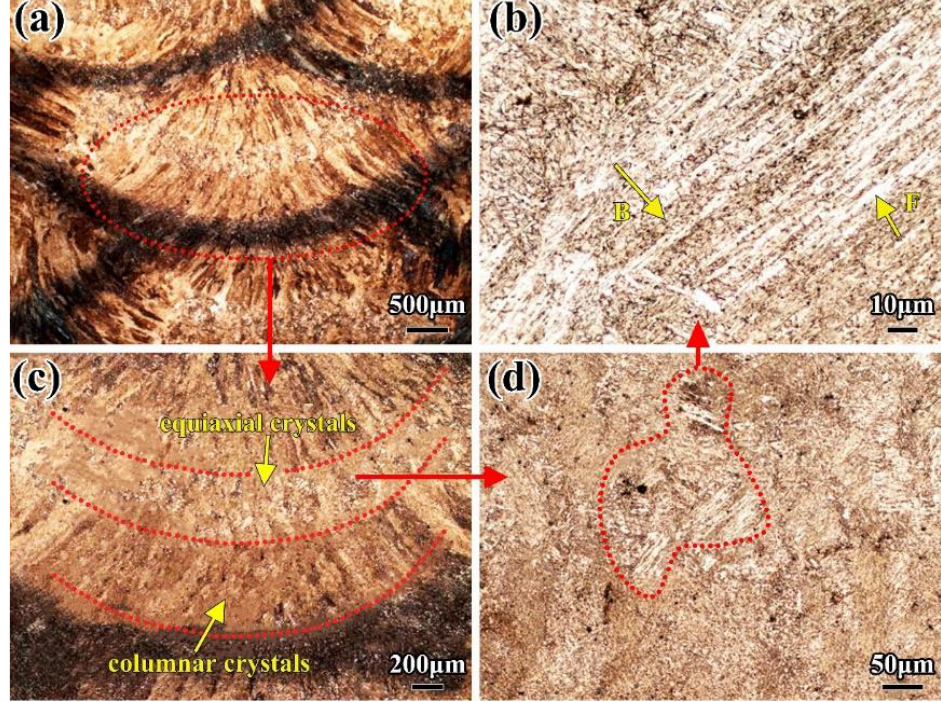
Figure 9. Microstructure of SMAW joint ( a ) Macro-photo in weld metal ( b ) Bainite ferrite in weld metal ( c ) Equiaxial and columnar crystals ( d ) Equiaxial crystals. F: ferrite; B: Bainite.